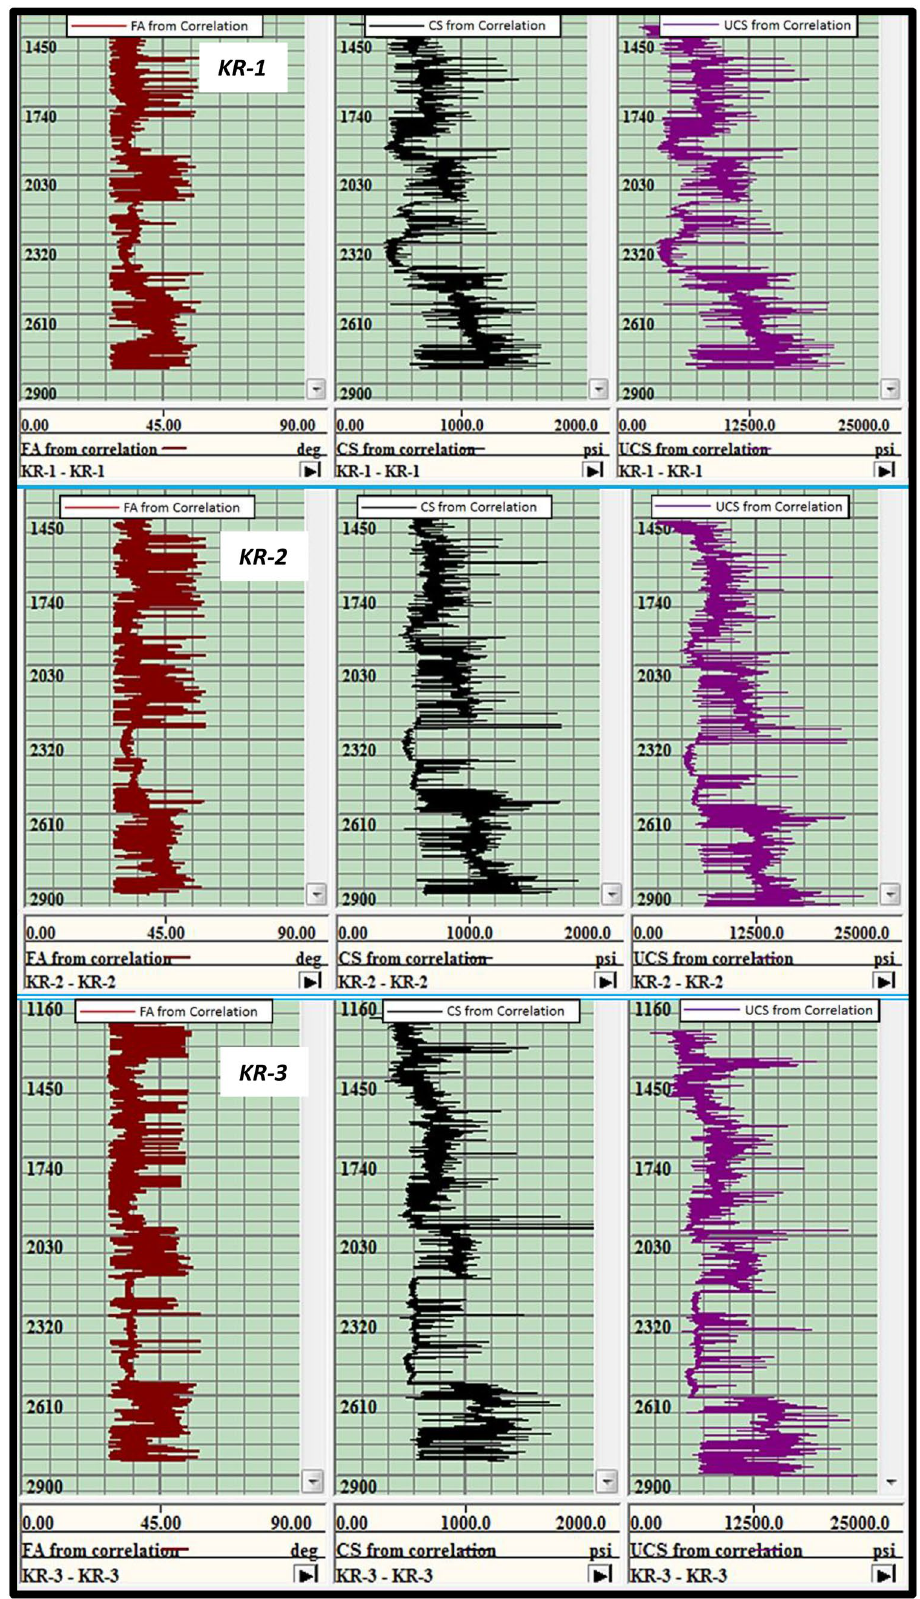
Fig. 7 Rock mechanical proper- ties for